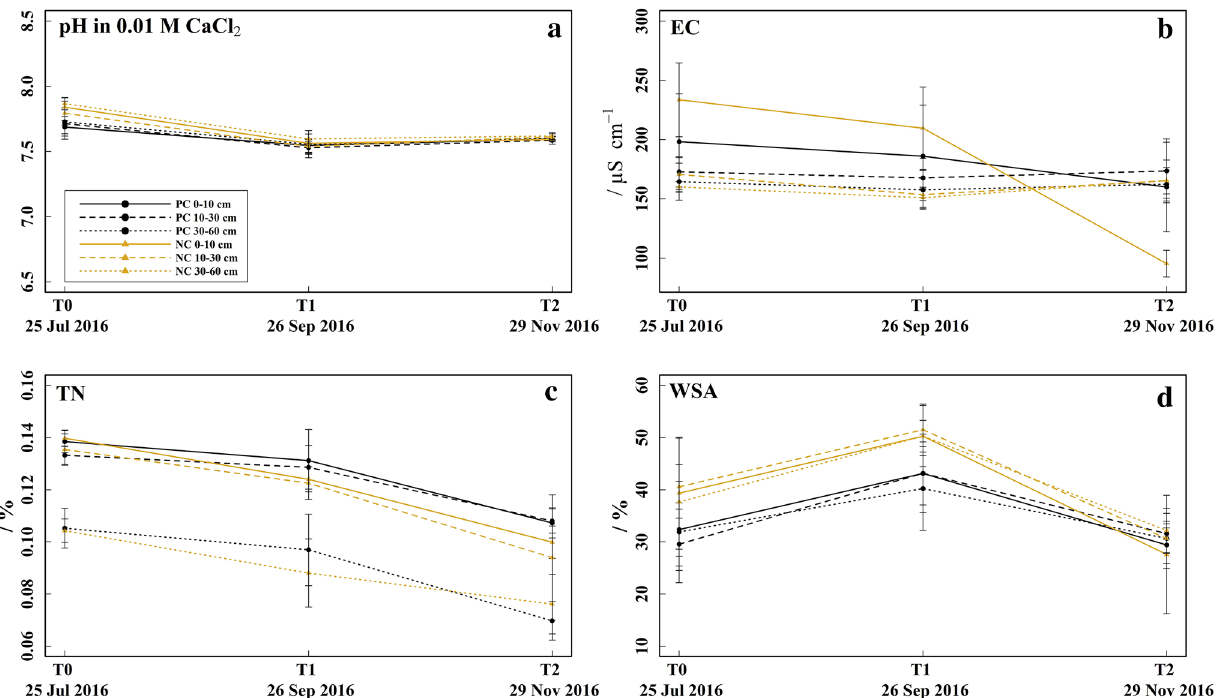
under plastic coverage (PC) and no coverage (NC), respectively, ) deter- 2 shown as mean with standard deviation (n = 5). b Electrical conduc- tivity (EC), c total nitrogen (TN), d water-stable aggregates